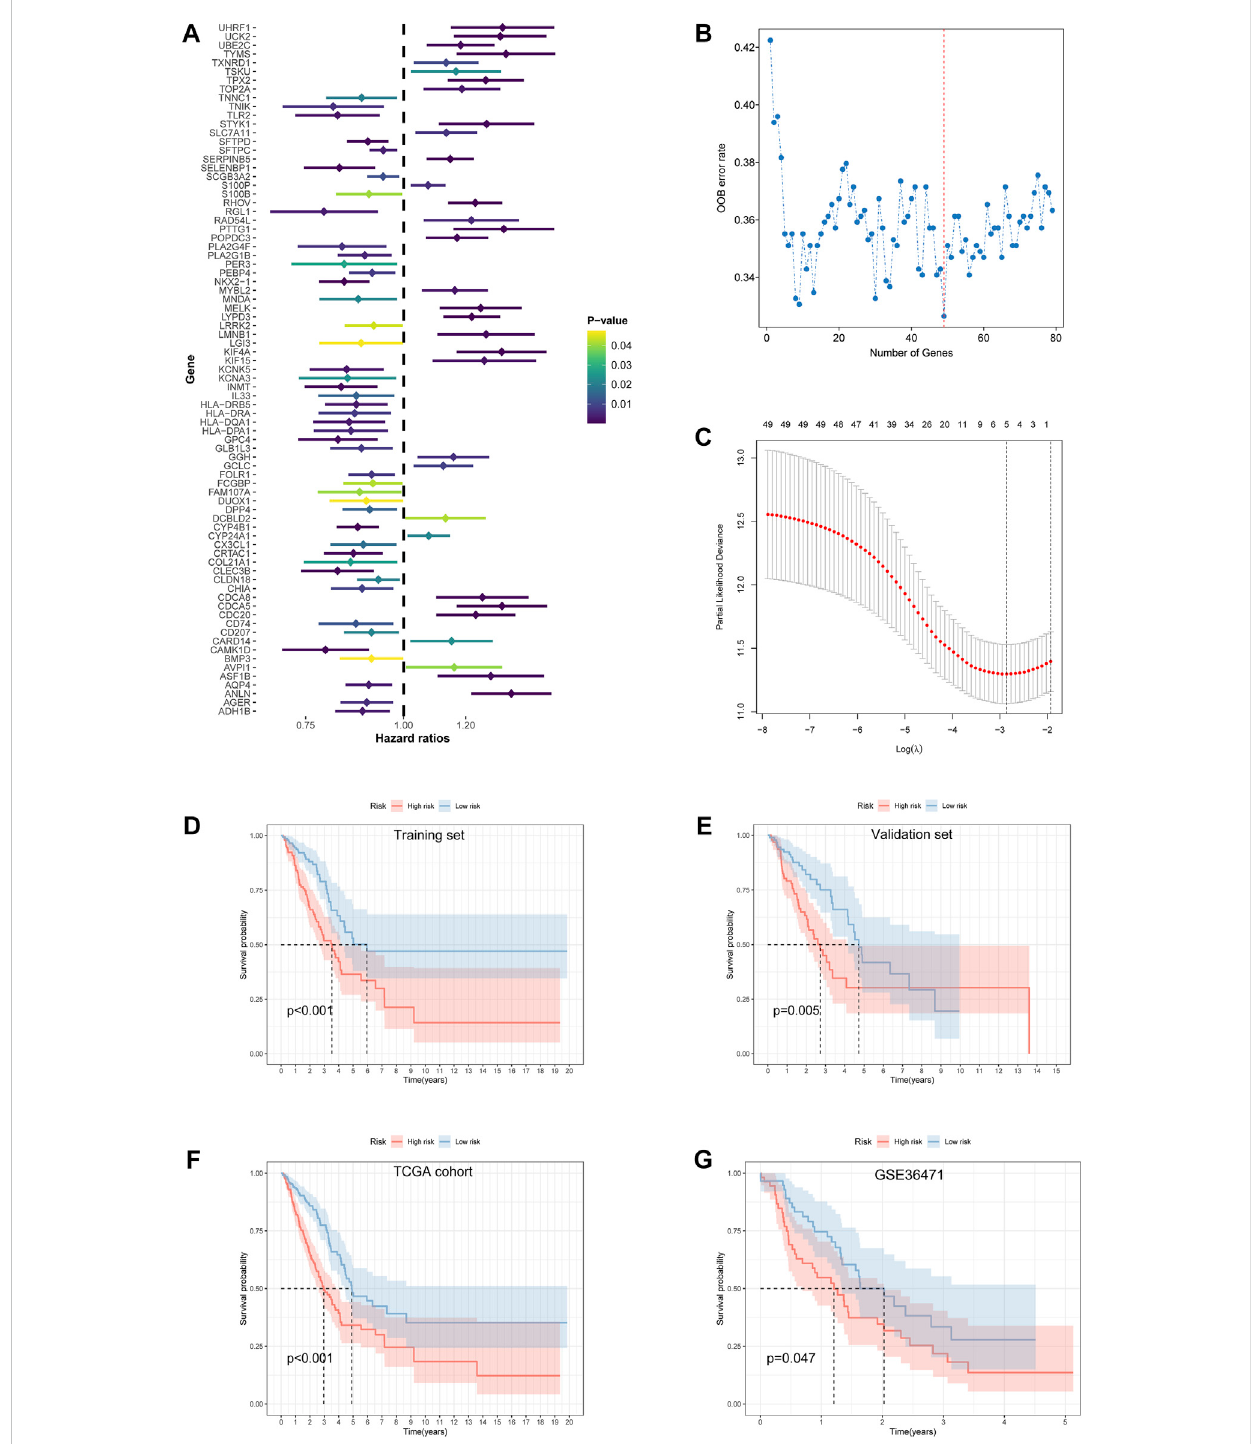
FIGURE 4 Feature selection and development of theprognosticrisk model. (A) Univariate Cox proportional hazard regression with 112 differentiallyexpressed ramRNAs. (B) The relationship of the “ out-of-bag ” error rate and gene numbers included in the random forest model by the method of sliding window sequential forward feature selection. (C) Solution paths of partial likelihood deviance and lambda in the least absolute shrinkage and selection operator Cox regressionmodel.Left black dotted lines represented the minimum lambda and its corresponding number of genes, which was optimal. (D – G) Survival differences between the low- and high-risk groups in thetraining set, validation set, TCGA cohort, and GSE36471 estimated by the log-rank test. TCGA: The Cancer Genome